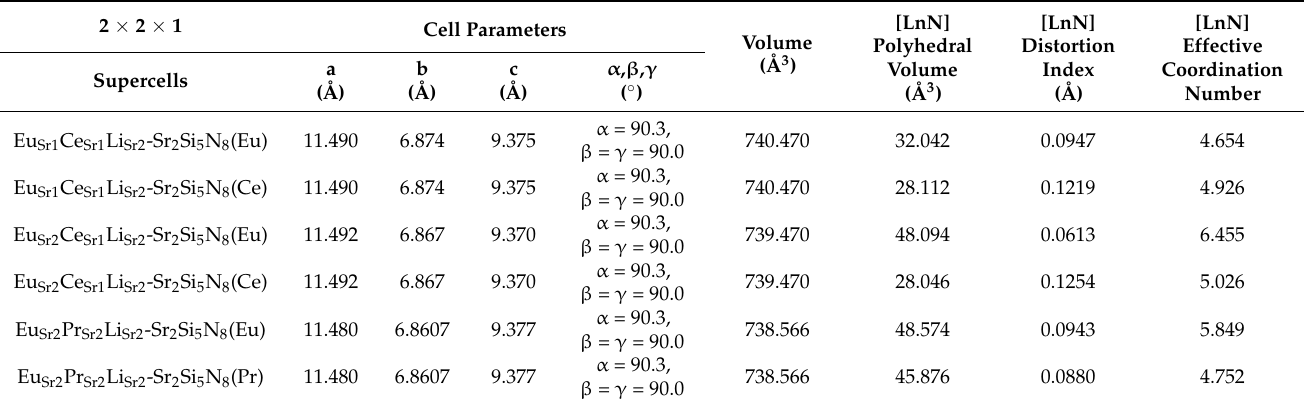
Table 3. Cell parameters and [LnN] polyheral structures of Sr 2 Si 5 N 8 co-doped Eu 2+ /Ce 3+ /Li + and Eu 2+ /Pr 3+ /Li + . 2 × 2 × 1